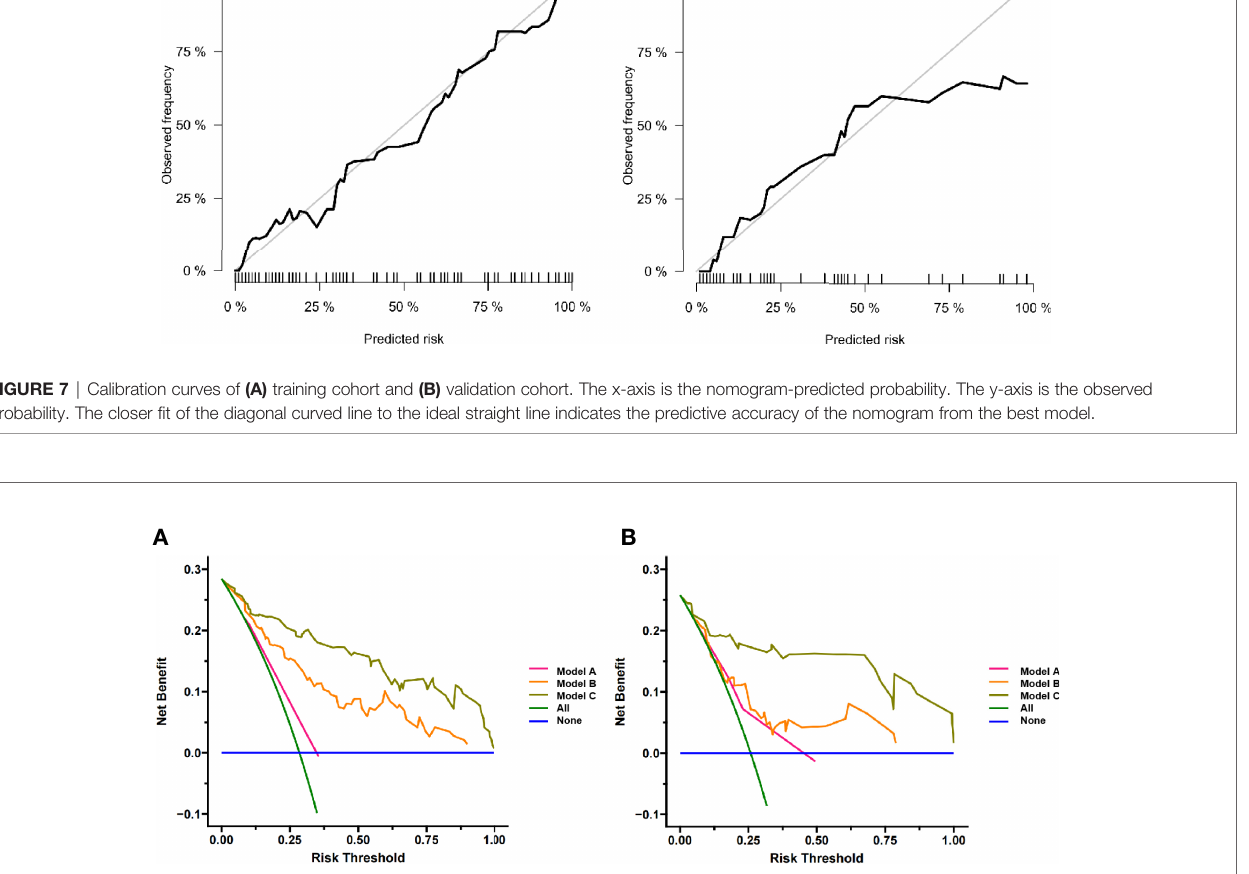
FIGURE 8 | Decision Curve analysis for three models in (A) training cohort and (B) validation cohort. The y-axis measures the net bene fi t. The pink line represents model A, the orange line represents model B and the brown line represents model C. The green line represents the assumption that all patients gained substantial bene fi t after NAC. The horizontal blue line represents the assumption that no patients gained substantial bene fi t after